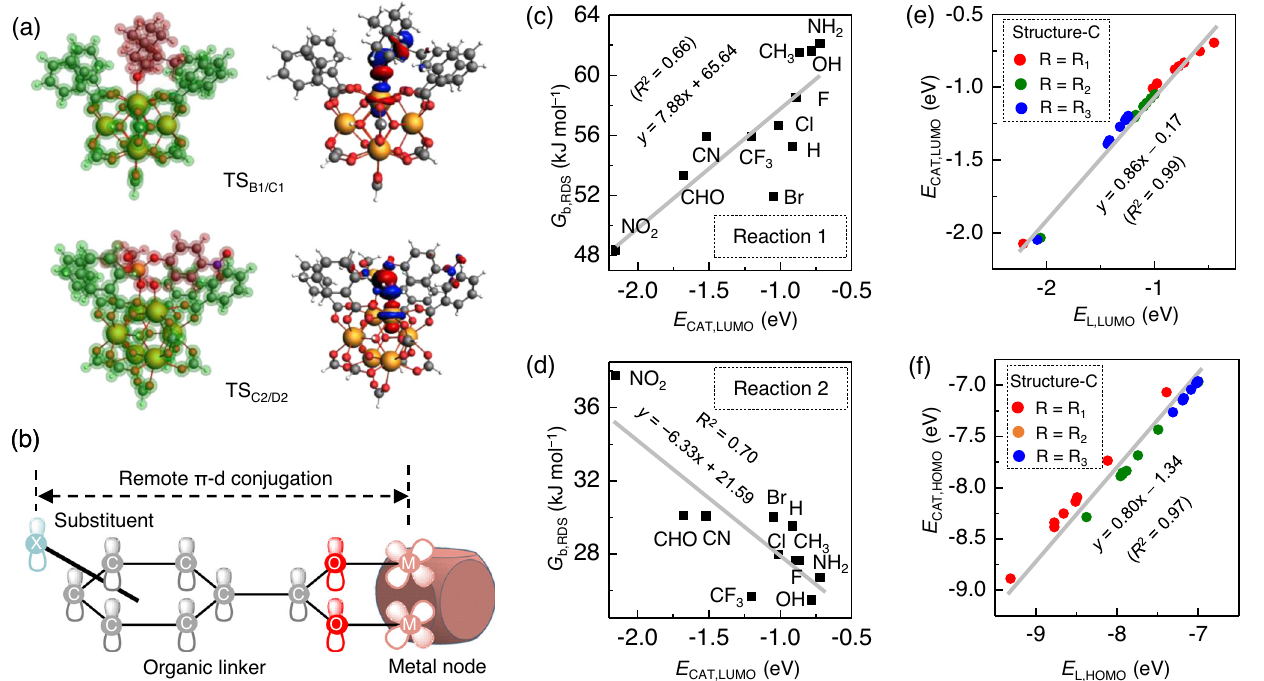
Fig. 5 Relationships between energy barriers and linker frontier orbital energies. a Orbital interaction analysis for rate-determining transition states. b Remote π -d conjugation between the linker substituent and nodal metal. c Plot of free energy barriers of the rate- determining step ( G b,RDS ) with catalyst LUMO energies ( E CAT,LUMO ) for Reaction 1. d Plot of G b,RDS with catalyst LUMO energies ( E CAT,LUMO ) for Reaction 2. e Plot of E CAT,LUMO with linker LUMO energy ( E L,LUMO ). f Plot of E CAT,HOMO with linker HOMO energy ( E L,HOMO ). The color setting for atoms in a , b : Zr, yellow; H, white; O, red; C, Eq. (2) indicates the plus or minus sign of Δ Q CAT , providing mechanistic insights into the catalytic mechanisms.